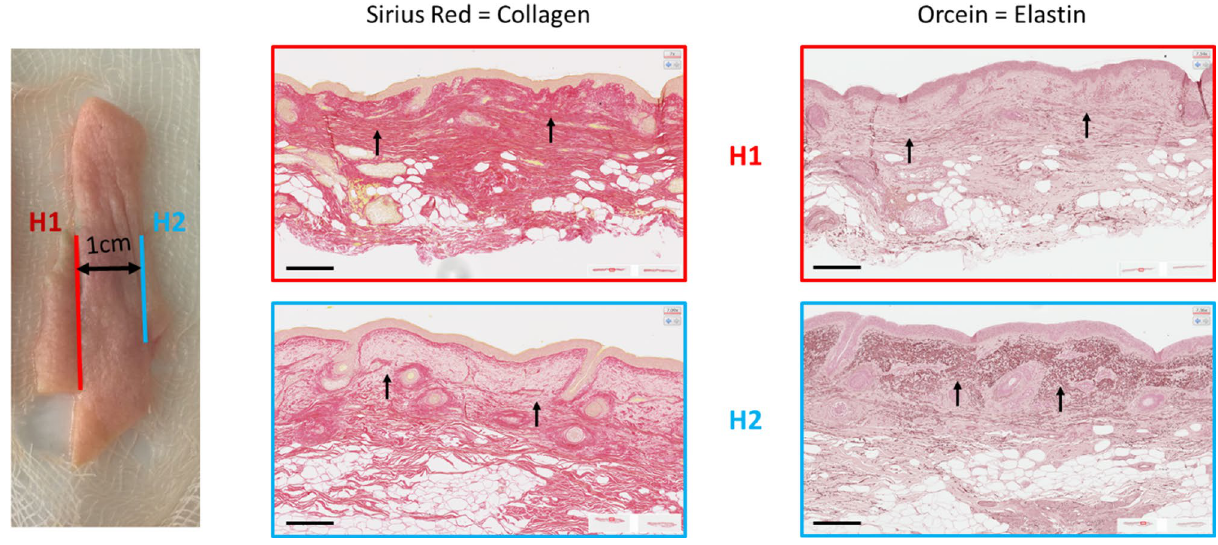
Figure 4. Sirius Red (left) and Orcein (right) stainings of histological cuts located 1 cm apart (× 10 magnification) on cheek skin. Arrows indicate the zone where the modification of the collagen and elastic network undergoes the most observable modifications. Scale bar is 250